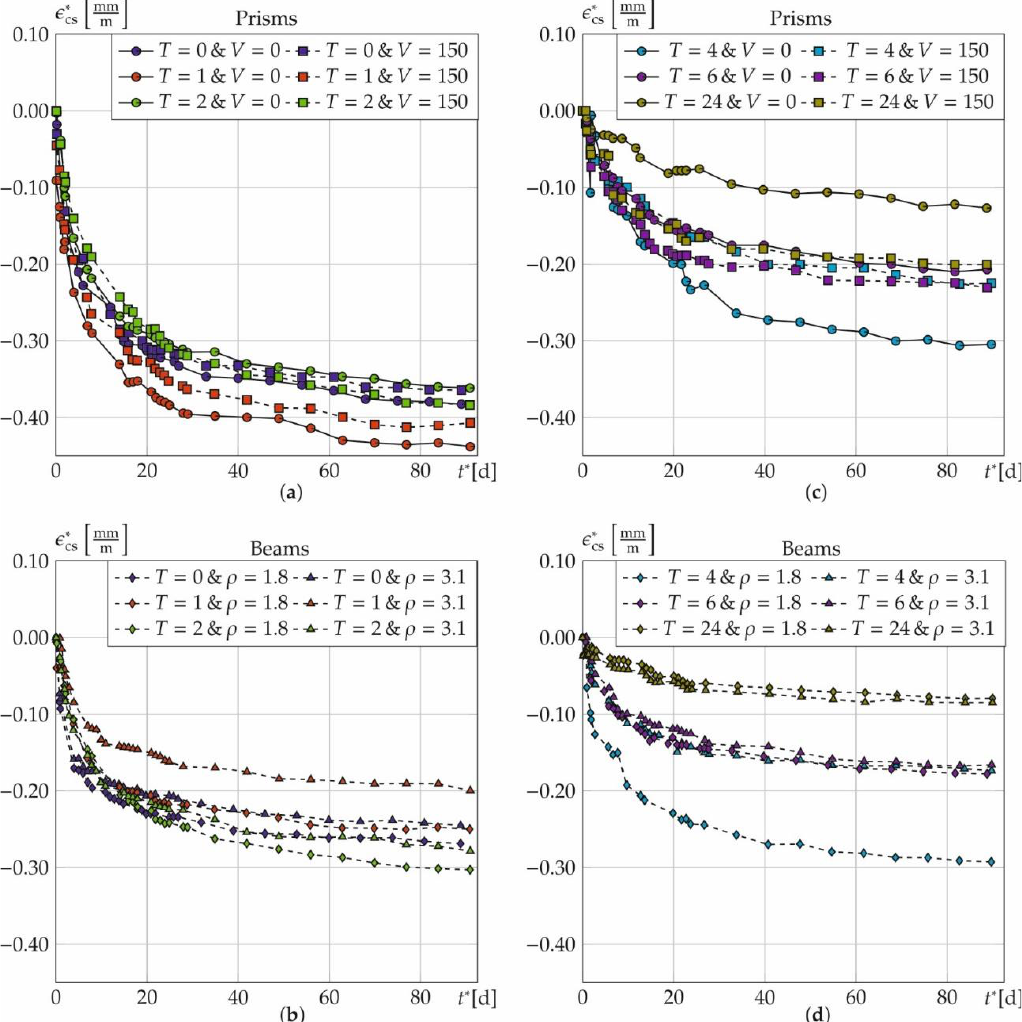
Figure 13. Results of the shrinkage strain ε cs* as a function of the fibre amount V [kg/m 3 ] for the prisms for T = 0, 1, 2 ( a ) and T = 4, 6, 24 ( b ) or rebar ratio ρ [%] for the beams for T = 0, 1, 2 ( c ) and T = 4, 6, 24 ( d ).